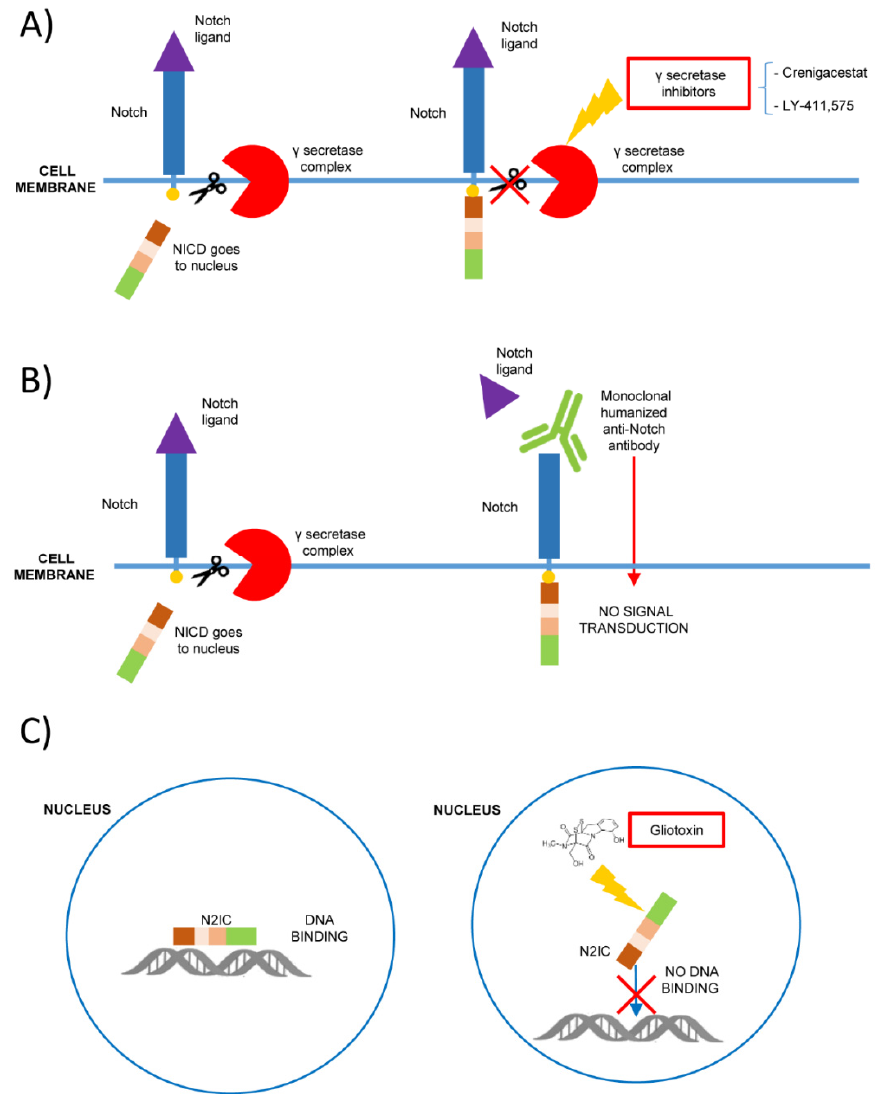
Figure 1. Mechanisms of Notch signaling inhibition as possible therapeutic strategies in hematologi- cal malignancies. ( A ) The inhibition of γ secretase-complex (i.e., with Crenigacestat or LY-411,575) prevents the proteolytic cleavage of Notch intracellular domain (NICD), blocking its signaling; ( B ) the binding with monoclonal humanized antibodies prevents Notch ligand interaction and the signaling activation; ( C ) gliotoxin is a specific Notch 2 inhibitor that binds Notch 2 intracellular domain (N2IC) blocking the DNA binding and preventing the target